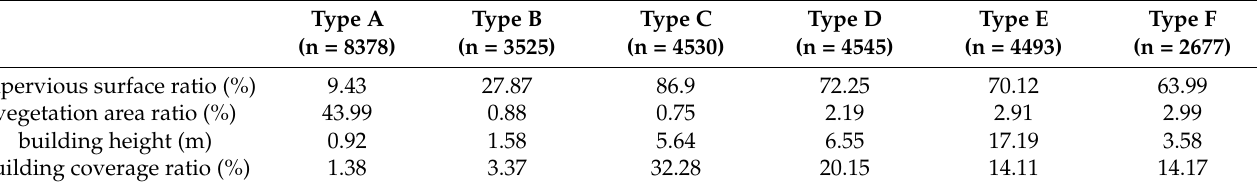
Figure 4. Results of classification of the study area. Table 2. Spatial characteristics for six types of urban space.